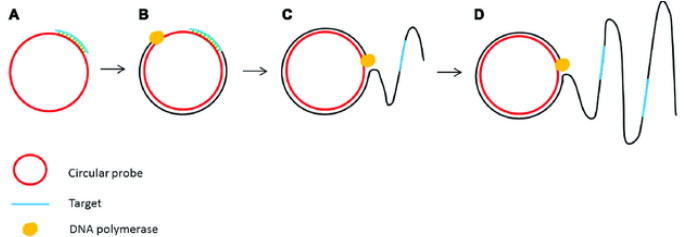
Figure 3. Schematic outline of rolling circle amplification (RCA). ( A ) A primer complementary to a region of a circular probe anneals to the circular template. ( B ) DNA polymerase initiates the DNA synthesis. ( C ) Strand displacement allows the continuation of DNA synthesis along the circular template. ( D ) DNA synthesis continues to generate a long ssDNA product [42]. (Copyright 2017 Lau and Botella.).